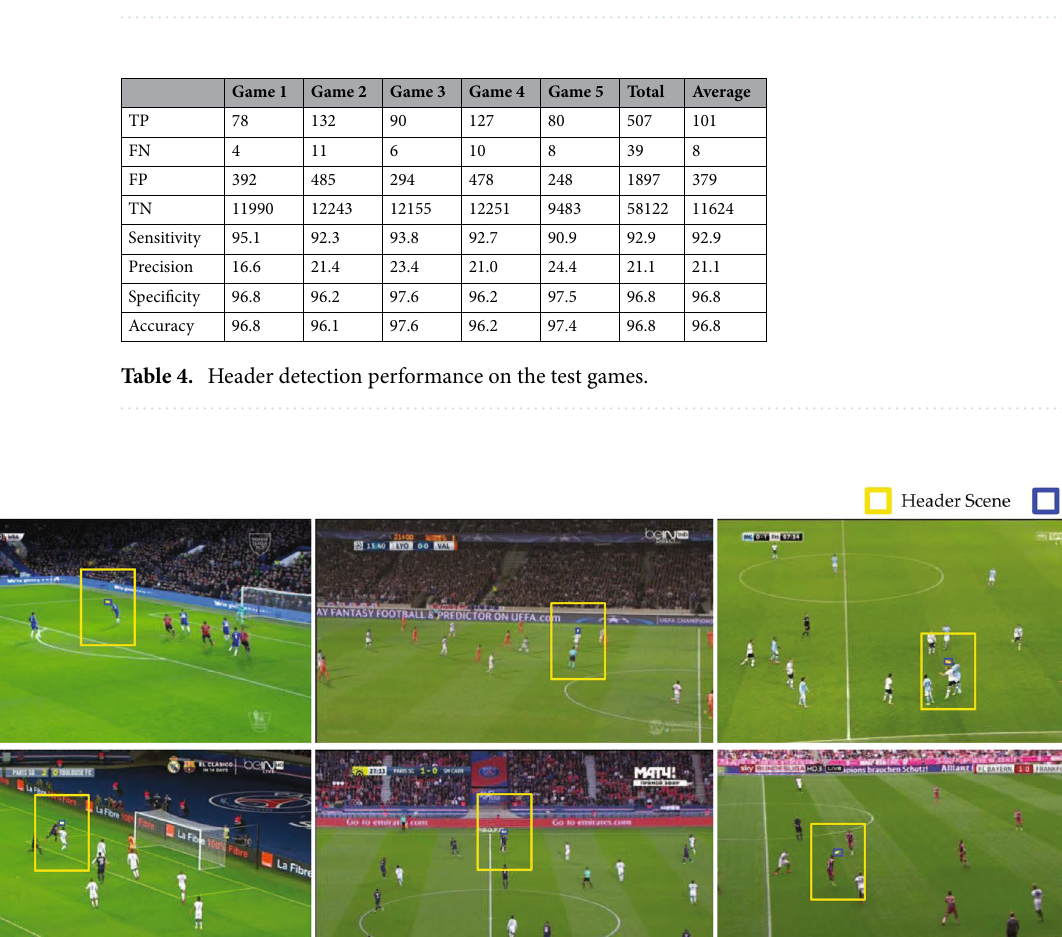
Table 3. Header detection performance on the validation dataset.